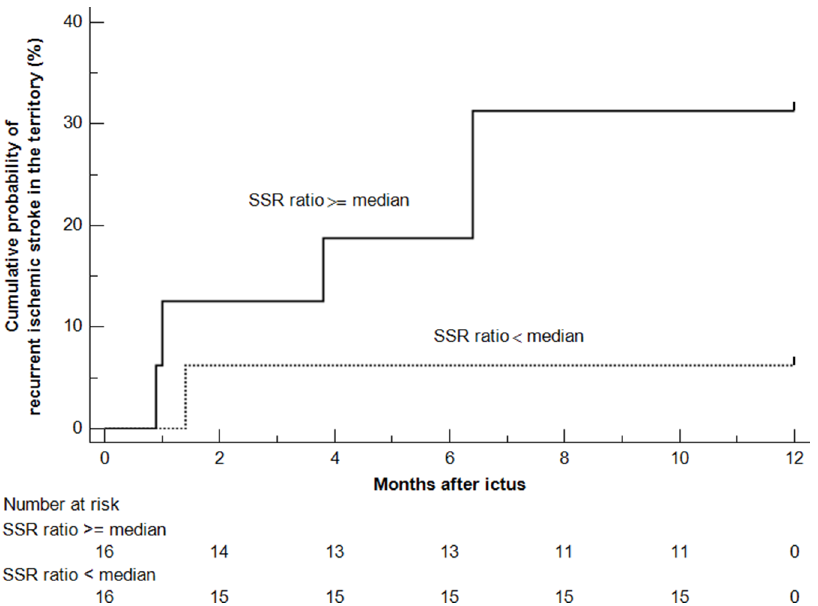
Figure 2. Kaplan-Meier curves for the cumulative probabilities of recurrent ischemic stroke in the territory (SIT) of the stenotic artery within 1 year after ictus, according to the shear strain rate (SSR) ratio ( $ or , median) as evaluated on the computational fluid dynamics models. Intracranial atherosclerotic lesions with a SSR ratio of $ median may relate to a higher risk of SIT, compared with lesions with a SSR ratio of , median (HR 5.483; 95% CI, 1.105–27.211; log-rank P=0.079).